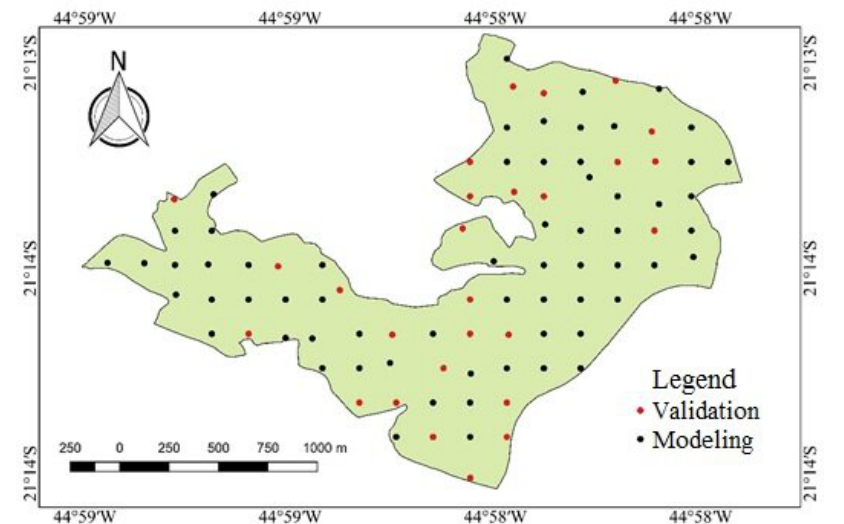
Figure 2. Sampling points used for modeling and validation collected from the study area located at Lavras, state of Minas Gerais,